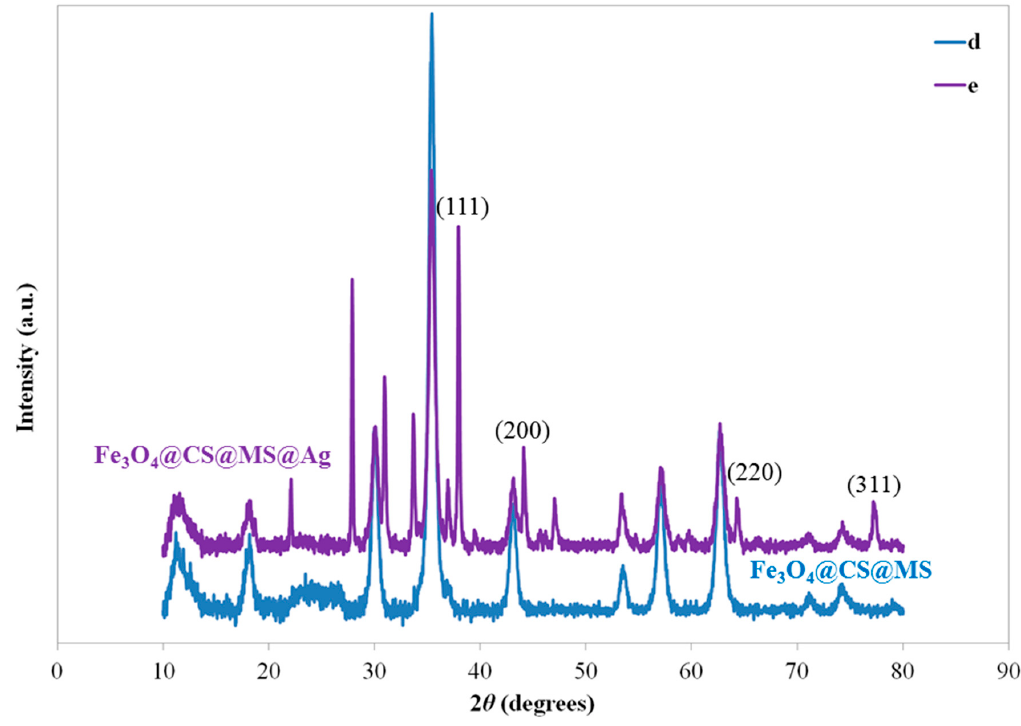
Figure 3. XRD pattern of Fe 3 O 4 @CS@MS (d, below) and Fe 3 O 4 @CS@MS@Ag (e, above).